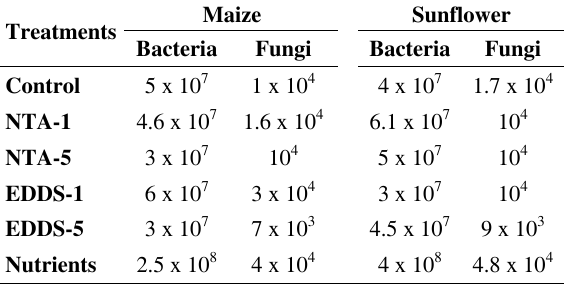
Table 4 . Influence of NTA, EDDS and nutrients on cfu of bac- teria and fungi in the rhizosphere of maize and sun- flower. The results present the mean ( n = 3) Maize Sunflower